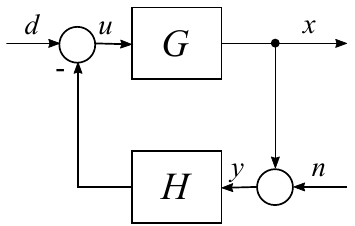
Figure 1. Control structure. Adapted from